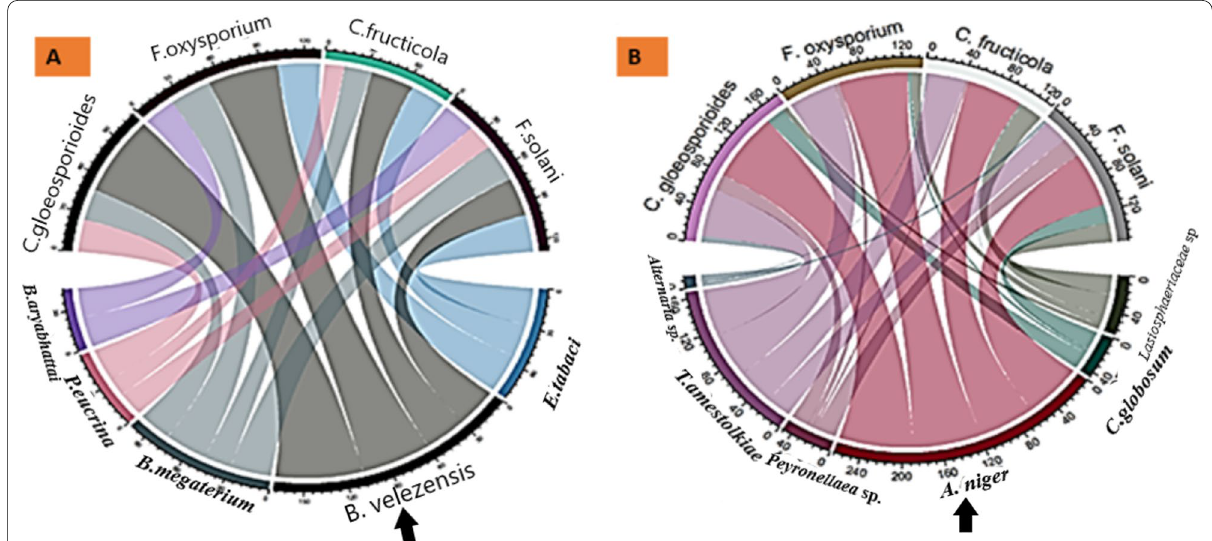
Fig. 3 Chord diagrams represent antifungal activities between phytopathogens and the most efficient bacterial and fungal isolates